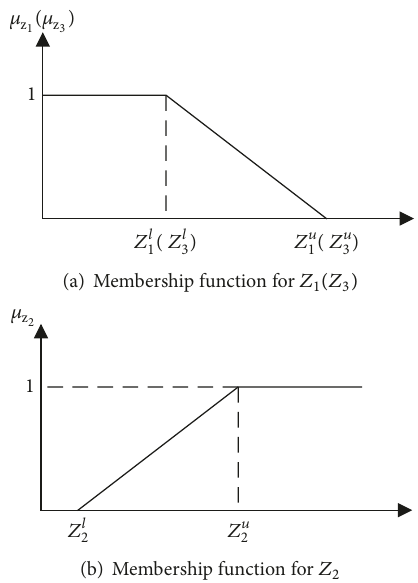
Figure 4: Fuzzification of the three objective